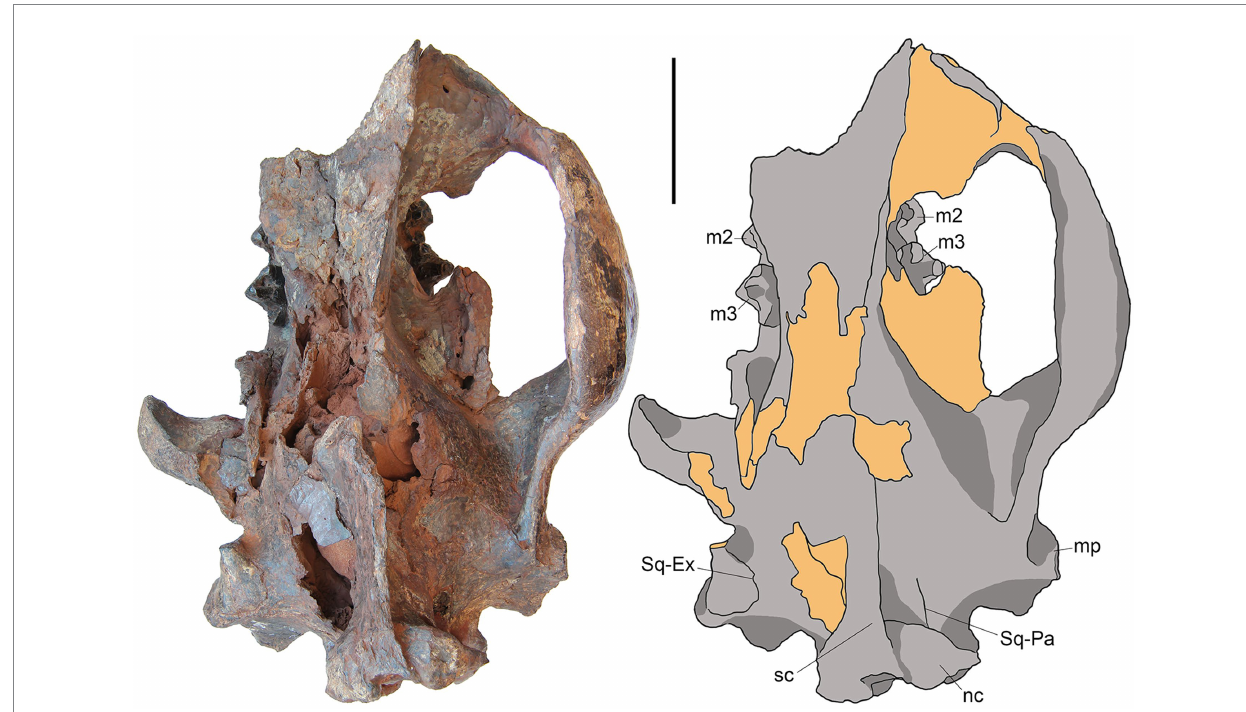
FIGURE 2 M. peregrinus , gen. et sp. nov., SYSU-M-5, holotype, a partial skull with associated mandibles in dorsal view (photograph and explanatory drawing). Youganwo Formation, upper Eocene, Maoming locality, Guangdong Province, China. mp, mastoid process; nc, nuchal crest; sc, sagittal crest; Sq- Ex, squamosal-exoccipital suture; Sq-Pa, squamosal-parietal suture. On this and following figures, the broken area and matrix are designated by the yellow color. Scale bar equals 5